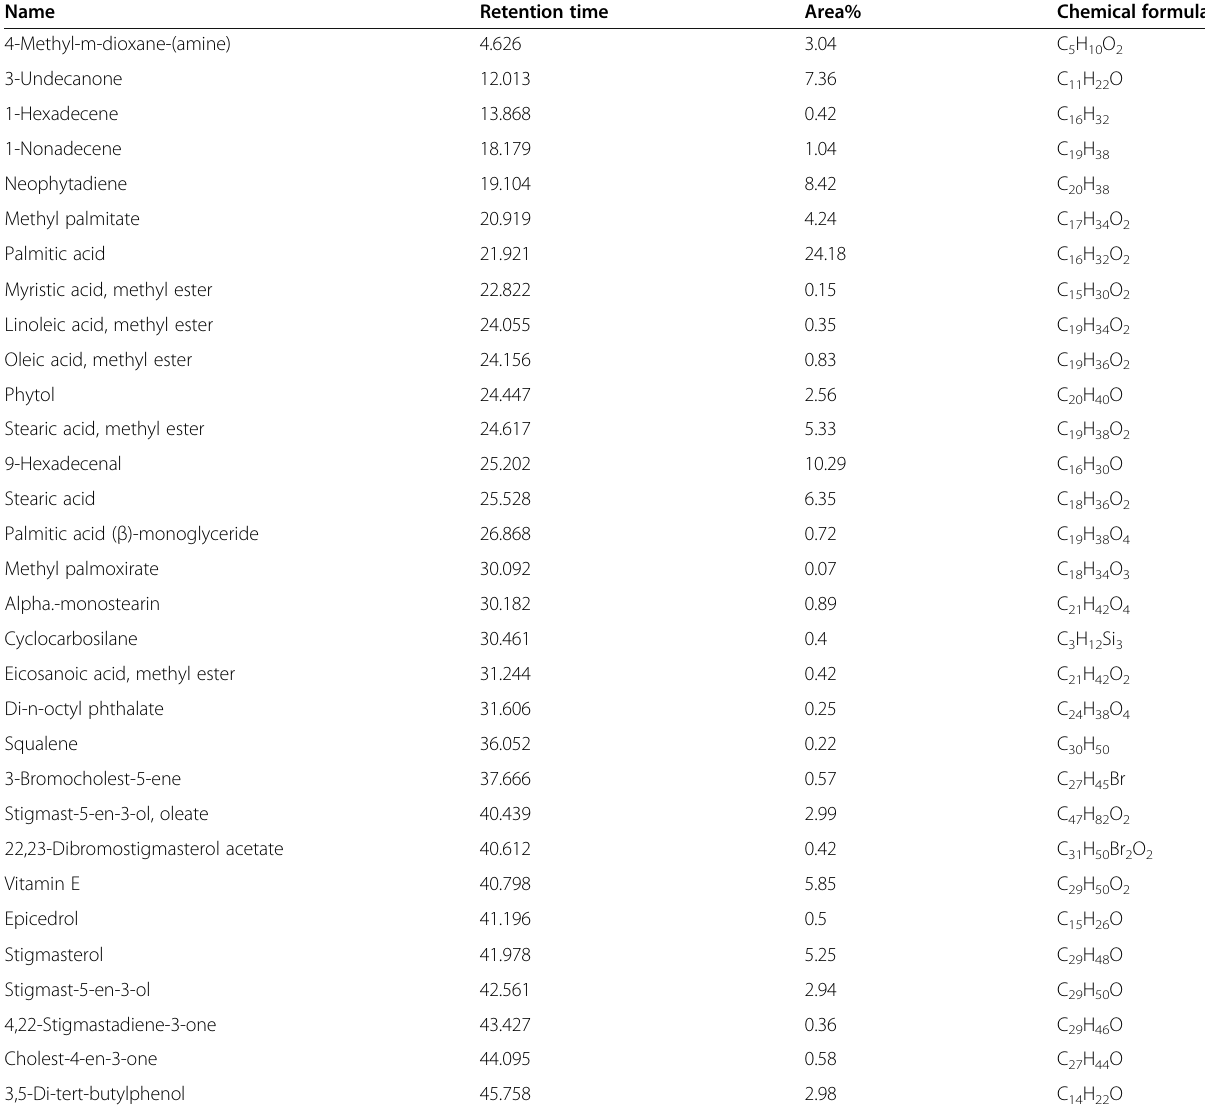
Table 4 Represents the compounds identified by gas chromatography mass spectrophotometry analysis of methanol extract of E. crassipes